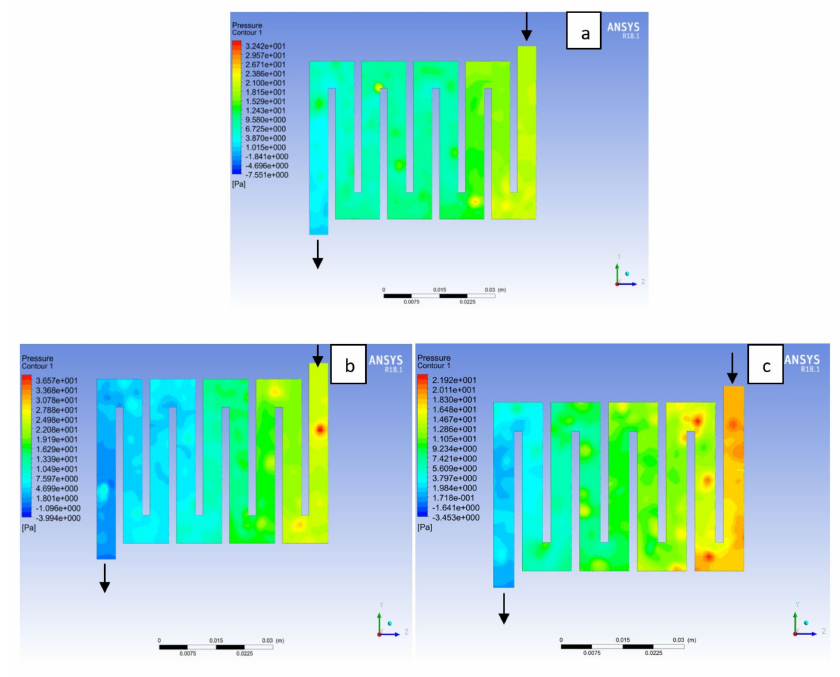
Figure 15. Pressure distribution at the cathode region (GDL/CL) for each material with temperature 323 K at 2.5 bar: ( a ) Aluminum, ( b ) Copper, ( c )